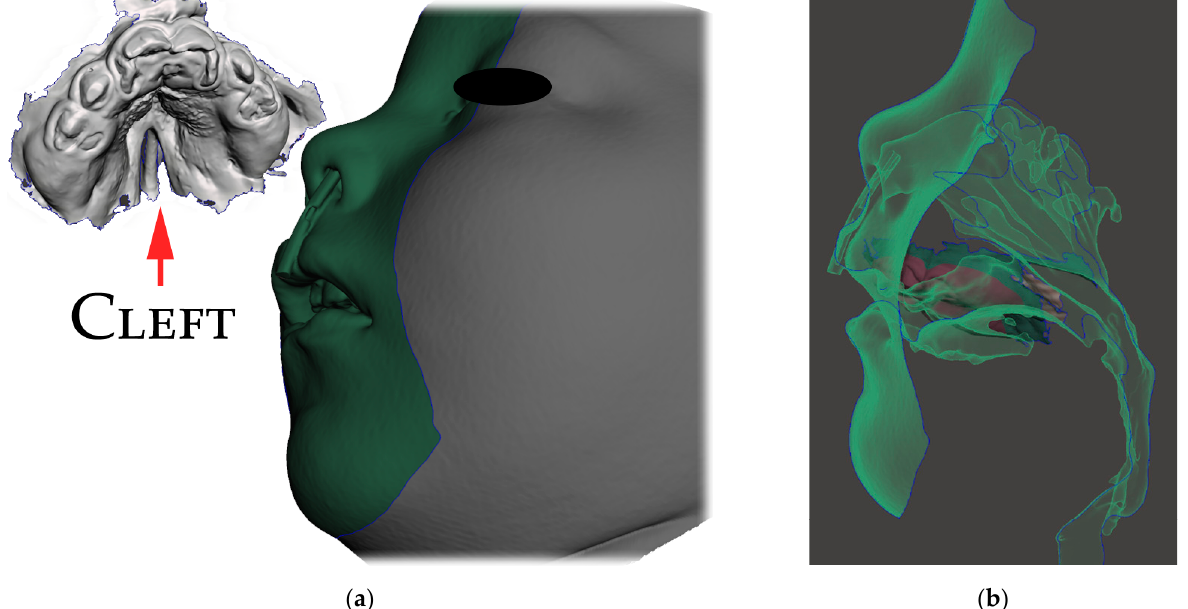
Figure 5. Segmented CT and intraoral scan: ( a ) surface of the face, intraoral cavity and relevant portions of the pharynx were segmented from CT to be aligned with the highly accurate intraoral scan of the upper alveoli and palate with the cleft on the left; ( b ) aligned intraoral scan with the rest of the segmented CT.